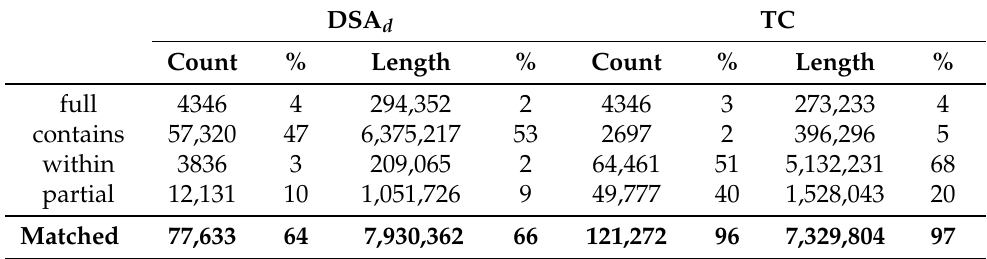
Table 4. Number and length (meters) of segments matched between DSA d and TC